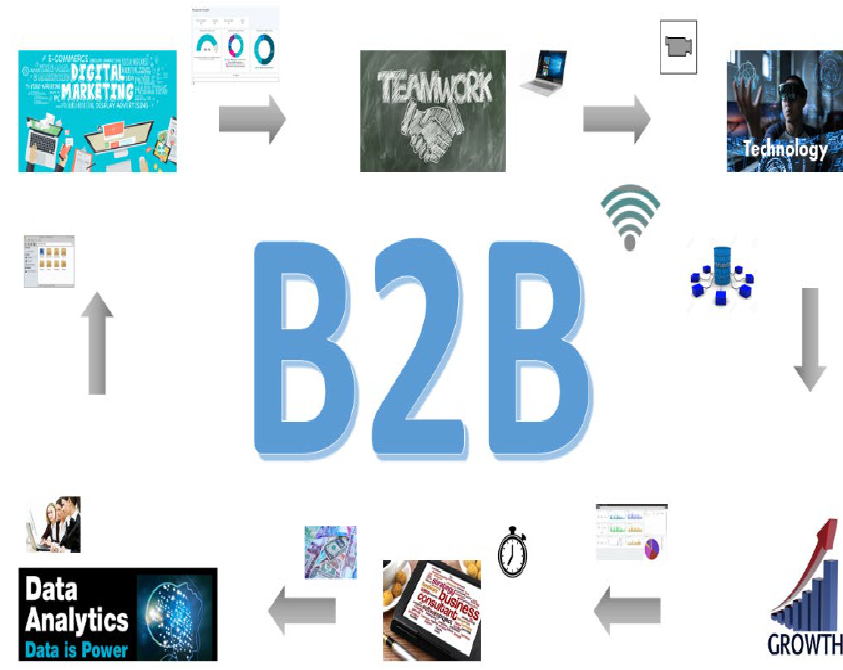
Figure 1. Basic architecture of eCommerce.